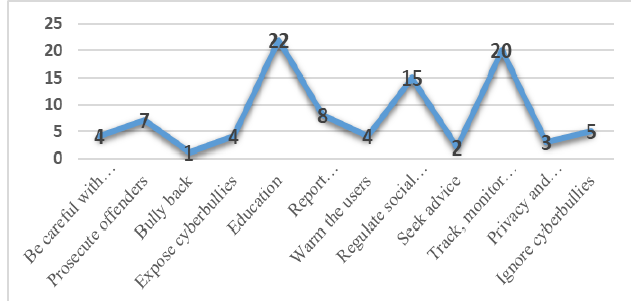
Figure 1: Other forms of suggestions to mitigate cyberbullying (Source: Fieldwork, 2019)